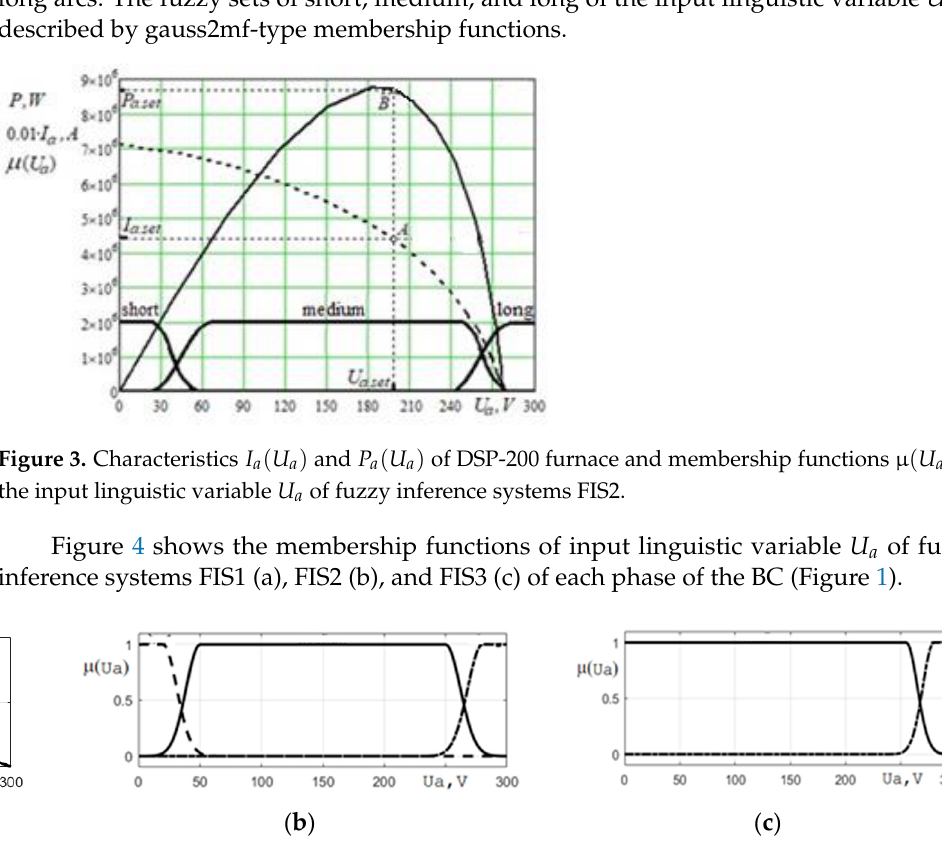
7 of 18 Figure 2. Structural block-scheme of the Simulink model of additive three-component fuzzy law (6) of the formation of a mismatch signal. Some partial control laws, (1), (3) and (4), are implemented in blocks 1, 2, and 3, re- spectively. Prompt determination of the values of the coefficients 𝑘 1 , 𝑘 2 , 𝑘 3 of model (6) is realized in the fuzzy output systems, FIS1, FIS2, and FIS3, respectively. Prompt calcu- lation of their values is performed as a function of actual voltage values on the arcs 𝑈 𝑎 of the corresponding phase. Operational control of arc voltages 𝑈 𝑎 (𝑡) is performed by the device [30] based on an artificial neural network. The components of additive functional (6) are continuously formed at the outputs of multiplication blocks Prod1, Prod2, and Prod3, which are fed to output adder S, where, according to model (6), the EM mismatch signal 𝑈 𝑟 (𝑈 𝑎 , 𝐼 𝑎 ) of the corresponding phase is formed. Based on the analysis of the functional properties of laws (1), (3) and (4), it is proposed to implement each of them in the process of regulating arc lengths in certain ranges of arc voltage changes (EM states): differential law (2) in the range of short arcs (including the modes of operational short circuits); the law of voltage (3) works in the zone of middle lengths of arcs; and the law of impedance (4) in the interval of long arcs (also in the modes of arc breaks). The input linguistic variable of the FIS blocks (Figure 2) is the arc voltage of the corresponding phase 𝑈 𝑎 , and their output linguistic variable is the value of weights 𝑘 1 , 𝑘 2 , and 𝑘 3 . Figure 3 shows external characteristics 𝐼 𝑎 (𝑈 𝑎 ) and power characteristics 𝑃 𝑎 (𝑈 𝑎 ) of the arc furnace DSP-200, which are reproduced in its Simulink model. The same figure shows the graphical dependences of membership functions 𝜇(𝑈 𝑎 ) of the fuzzy sets, short,